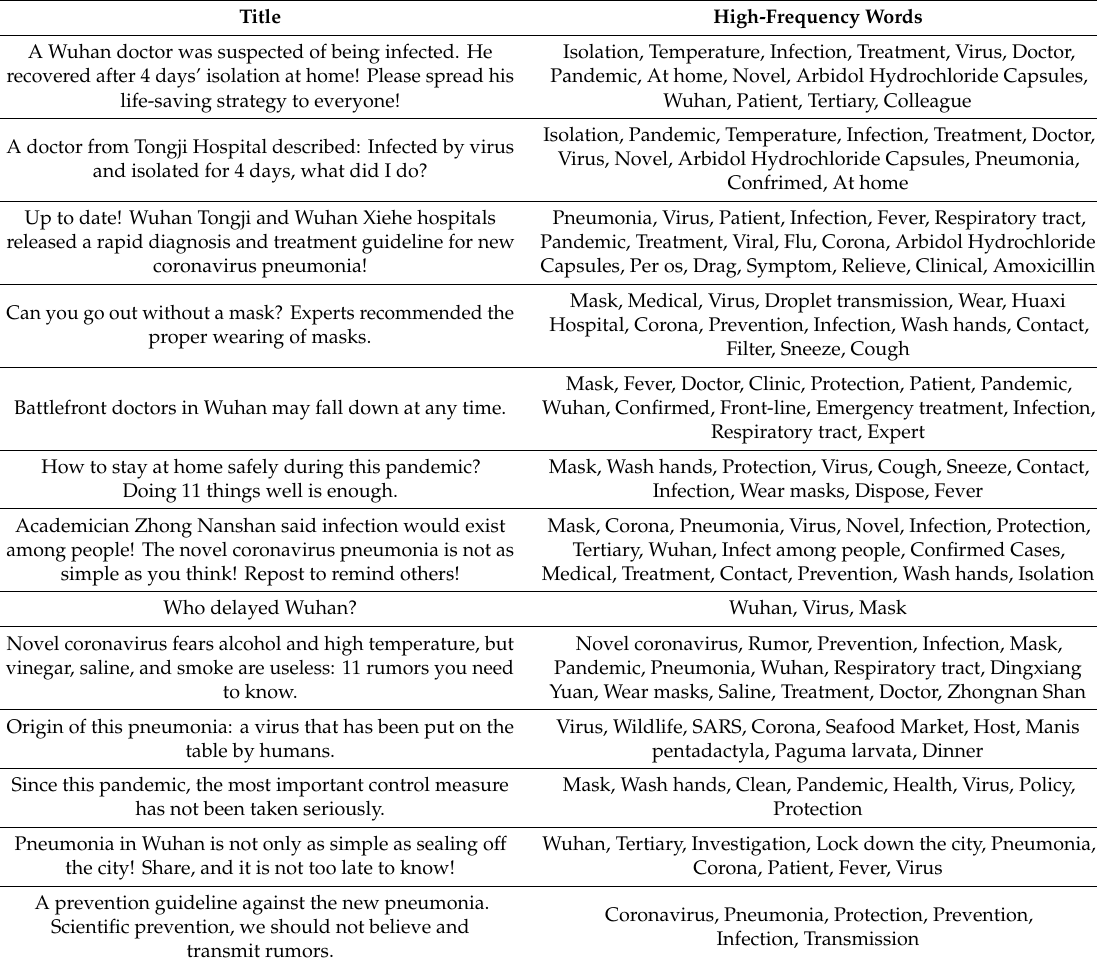
Table 8. High-Frequency Words in each